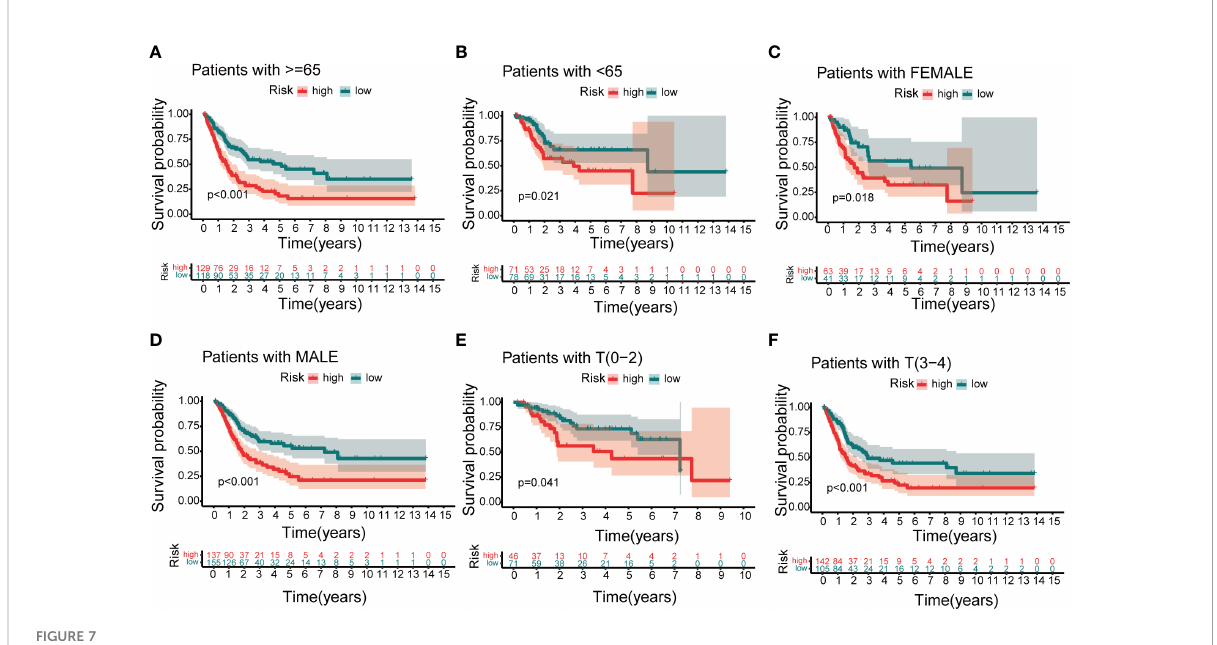
FIGURE 7 The clinical utility of the risk score. (A, B) Age. (C, D) Gender. (E, F)